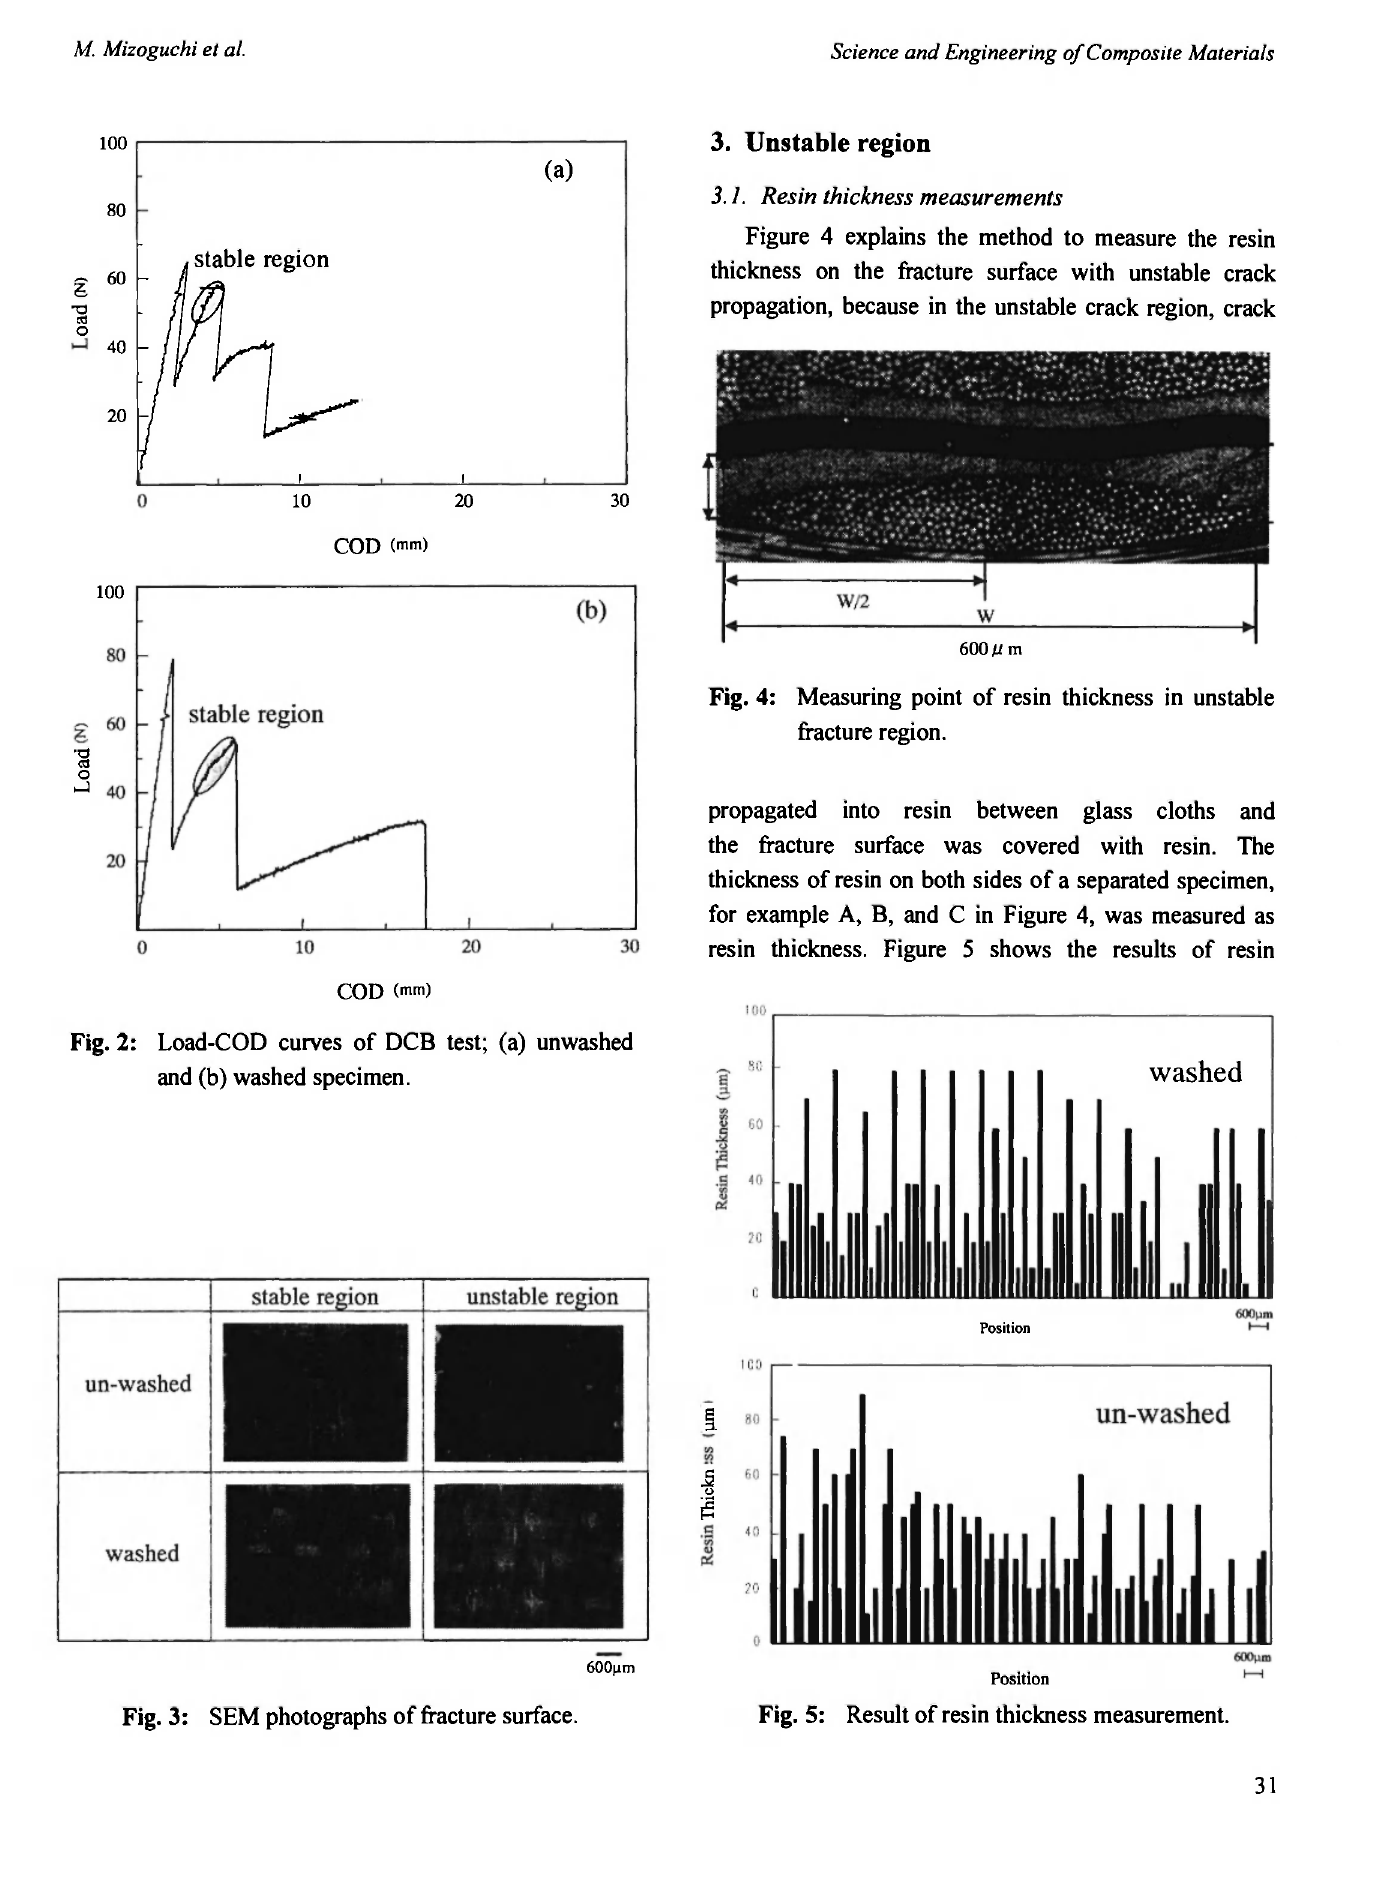
Fig. 4: Measuring point of resin thickness in unstable fracture region.